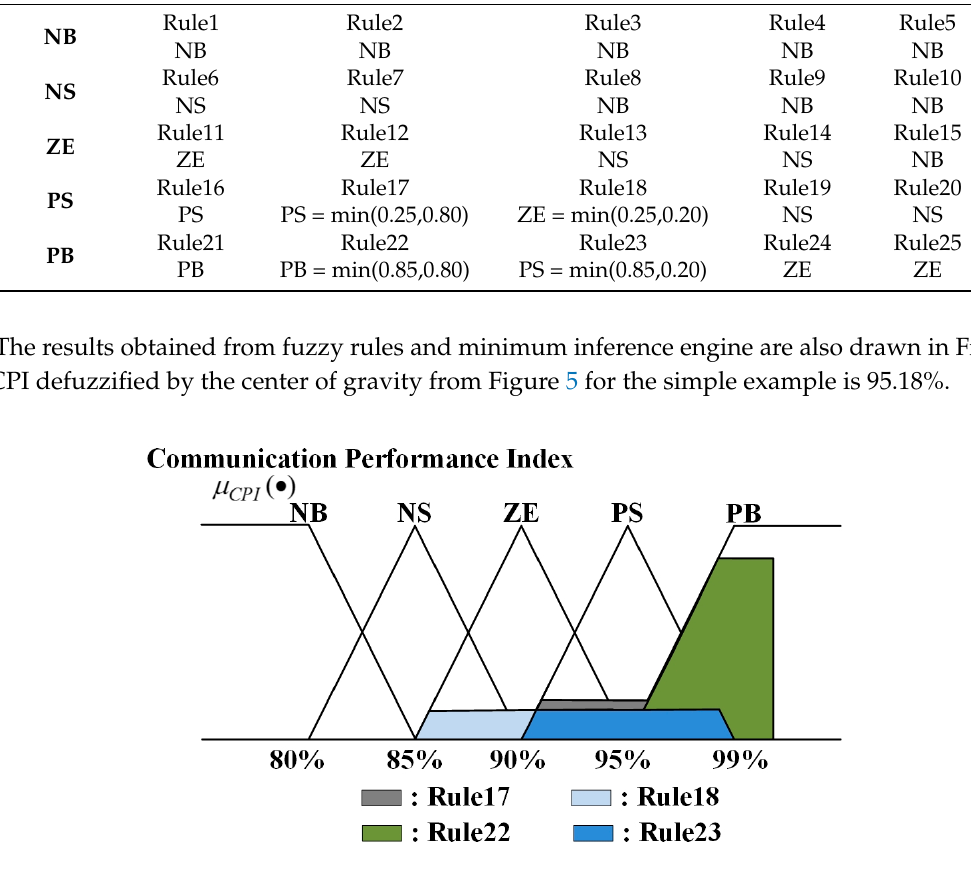
Table 2. Results of Activated Fuzzy Rules. Figure 4. Minimum Inference Engine. ( a ) Reading Success Rate; ( b ) Response Rate.